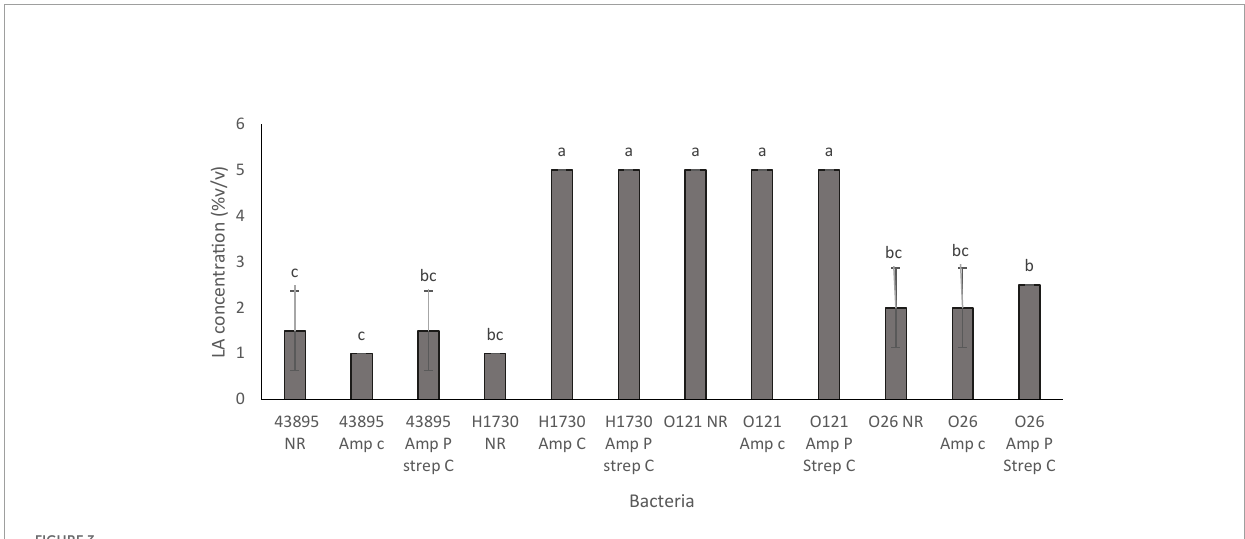
FIGURE3 Bactericidal concentrations of lactic acid for the O157:H7 STEC– E. coli O157:H7 43895 (43895) and E. coli O157:H7 H1730 (H1730) and non O157:H7 STEC- E. coli O121:H19 (O121) and E. coli O26:H11 (O26) with no resistance (NR), plasmid-based ampicillin resistance (amp P) and a combination of plasmid-based ampicillin resistance and streptomycin resistance through incremental exposure (amp P Strep C). Significant differences among strains have been denoted by different